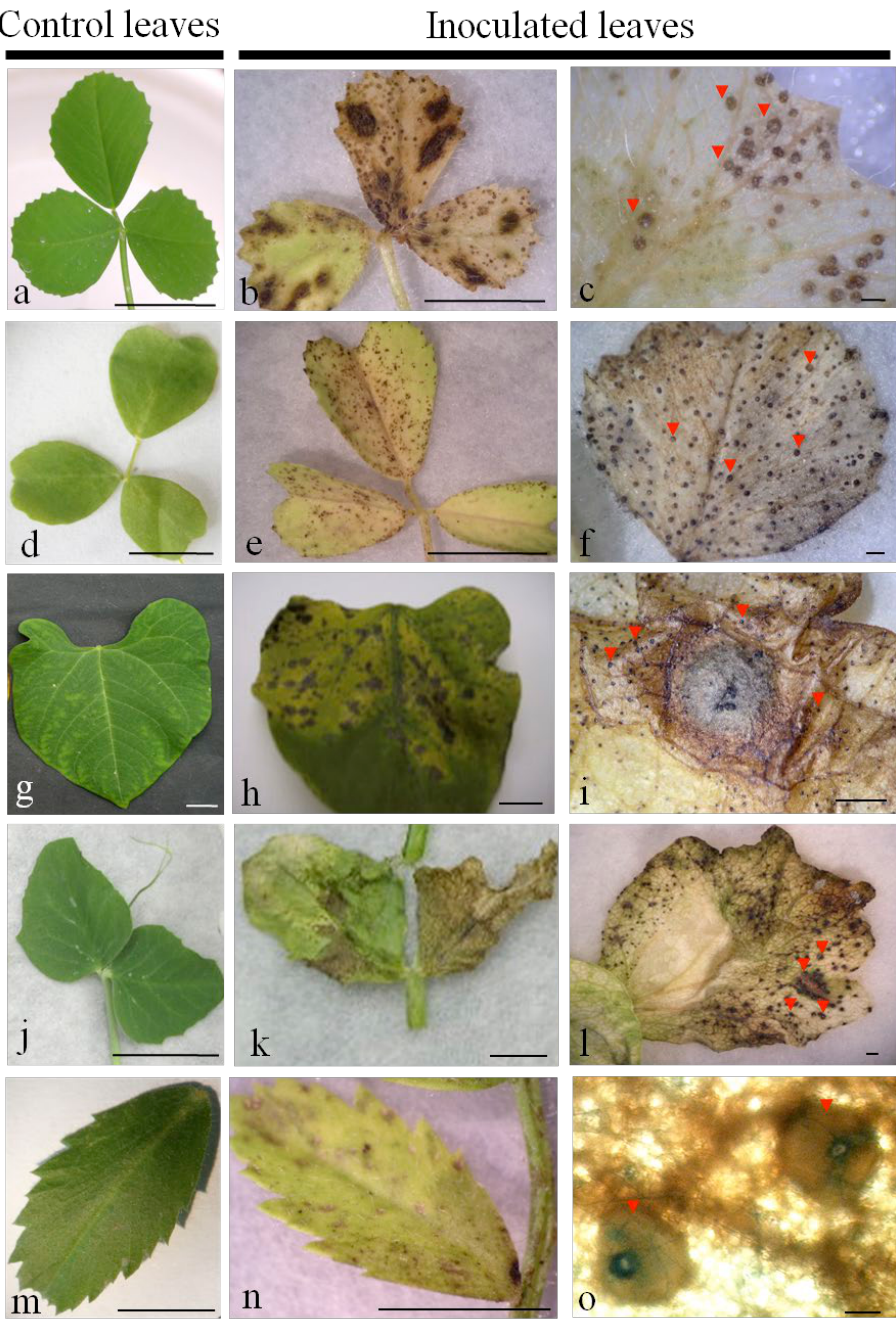
Figure 3. Macroscopic symptoms on control (a, d, g, j and m) and Phoma medicaginis inoculated leaves (b, e, h, k and n) of legumes and microscopic observations of pycnidium (red arrows) production of this pathogen on inoculated leaves (c, f, i, l and o) at 30 days post inoculation. a‒c: Medicago truncatula (line F83005.5) leaves; d‒f: Medicago sativa (cv. Gabes) leaves; g‒i: Phaseolus vulgaris (cv. Coco blanc) leaves; j‒l: Pisum sativum (cv. Lincoln) leaves; m‒n: Cicer arietinum (cv. Chetoui) leaves; o: P. medicaginis pycnidia morphology on M. truncatula inoculated leaf. Bars correspond to 1 cm (a, b, d, e, g, h, j, k, m and n), 1 mm (c, f, i and l) and 100 µm